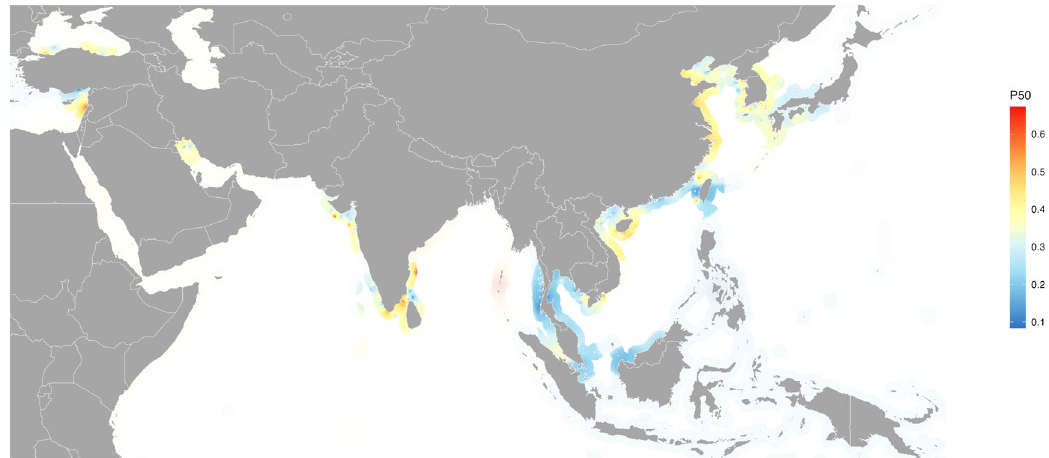
Fig. 5 Antimicrobial resistance in marine environments in Asia. Transparency re fl ects low survey density; areas of higher relative survey density are represented by increased